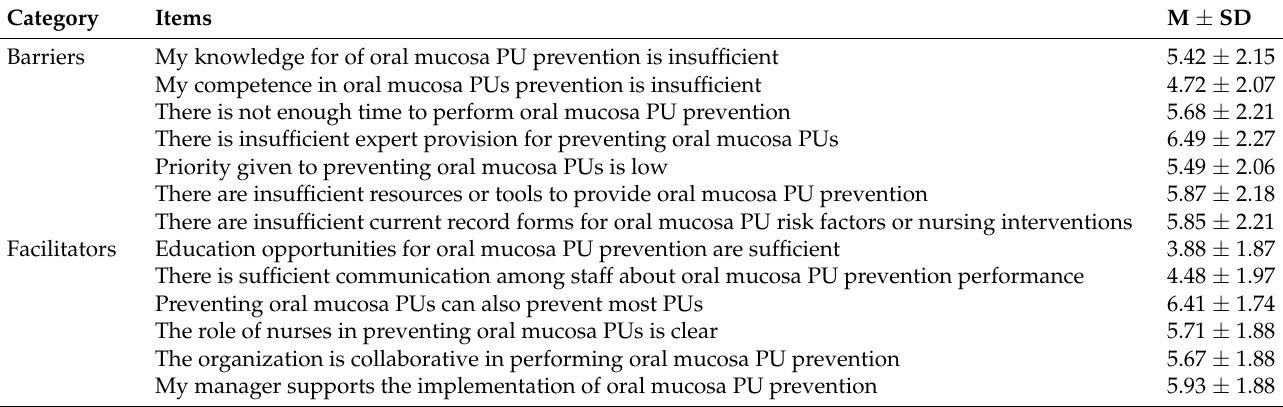
Table 3. Perceived barriers and facilitators of oral mucosa PU prevention (N = 112).